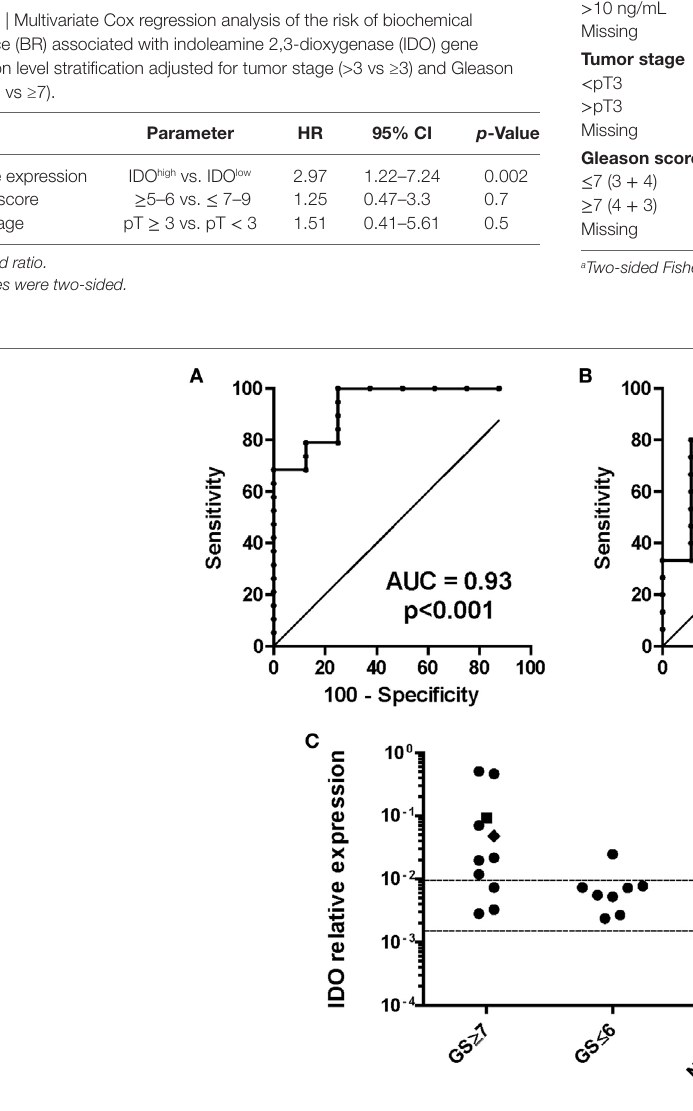
FigUre 7 | Indoleamine 2,3-dioxygenase (IDO) gene expression in urine sediments of individuals at risk of developing prostate cancer (PCa). IDO relative gene expression was analyzed in urine sediments from patients collected without previous manipulation of the prostate. (a) Definition of the thresholds for IDO mRNA for the probability of having PCa. The area under the curve (AUC) for the presence/absence of PCa was 0.93 (95% CI, 0.84–1.03%) with an optimal cutoff level of 0.0015 to dichotomize the patients into PCa positive and PCa negative (specificity 100%, sensitivity 75%). (B) Definition of the thresholds for IDO mRNA for the probability of having a clinically relevant (GS ≥ 7) than an indolent (GS ≤ 6) PCa. GS was evaluated from the biopsy or after prostatectomy, when available. The AUC for indolent/aggressive PCa was 0.84 (95% CI, 0.66–1%) with an optimal cutoff level of 0.0095 (specificity 89%, sensitivity 80%). (c) Cutoff a ( ≤ 0.0015), assignment to biopsy for the risk of having PCa (NPV = 100%, PPV = 82%). Cutoff b ( ≥ 0.0096), assignment to biopsy for the risk of having clinically relevant PCa (NPV 83%, PPV 88%). A value of 0.0479 (black square) represents the risk of having biochemical recurrence within 5 years from